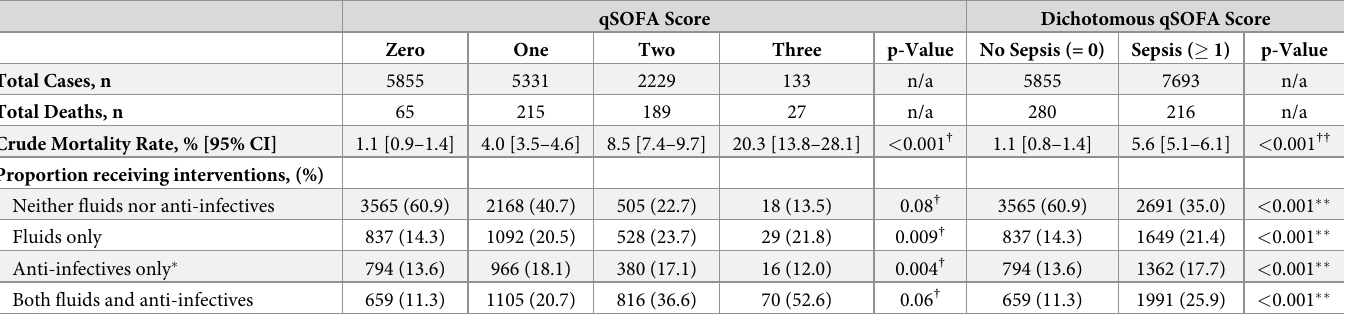
Table 2. Interventions and mortality for patients 2012–2019 stratified by qSOFA score (n =